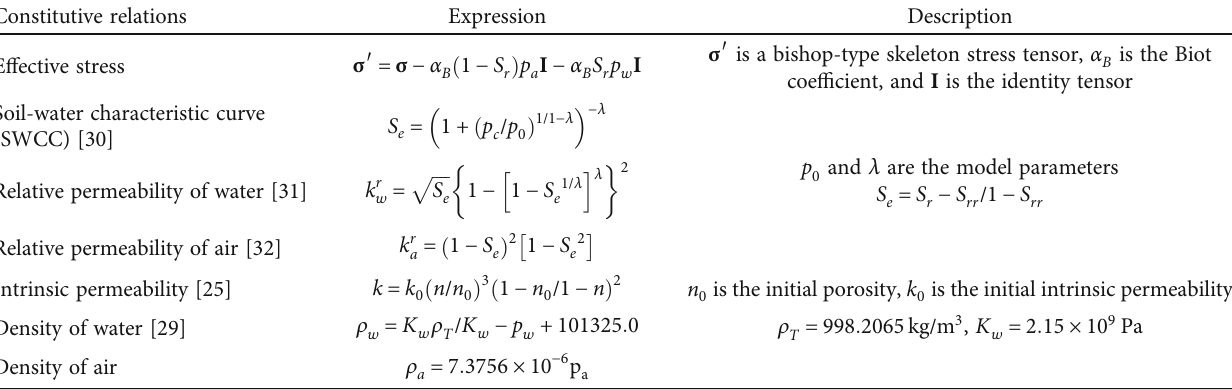
Table 1: Components of the constitutive